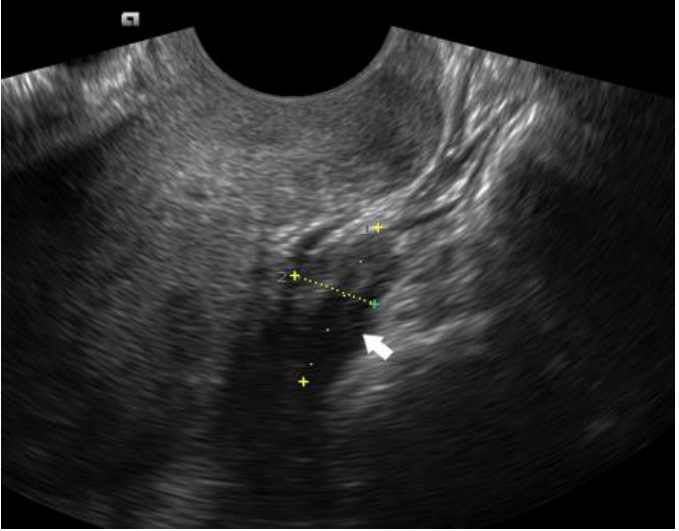
Figure 7. DIE nodule (white arrow) of the uterosacral ligament, appearing as a hypoechoic lesion within the white stripe.